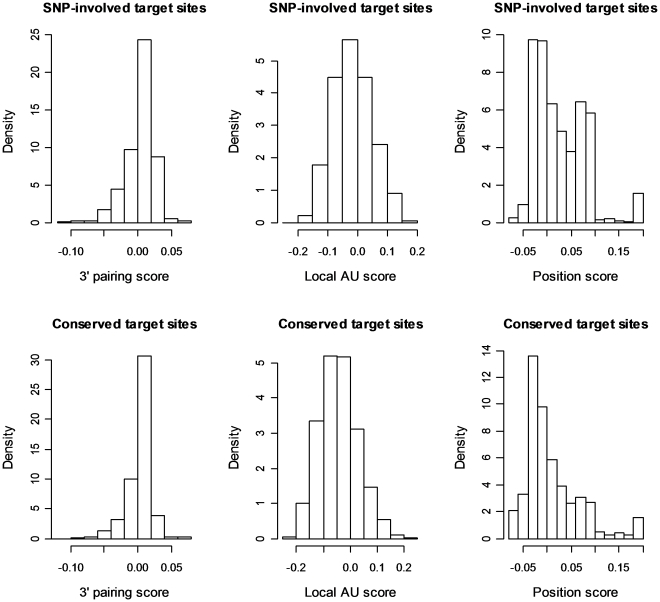
The density distribution comparisons of the context scores for the predicted SNP-involved miRNA target sites (non-conserved) and the conserved target sites reported by TargetScan.A target site with the score(s) deviating from zero to the negative direction is considered to be highly confident.